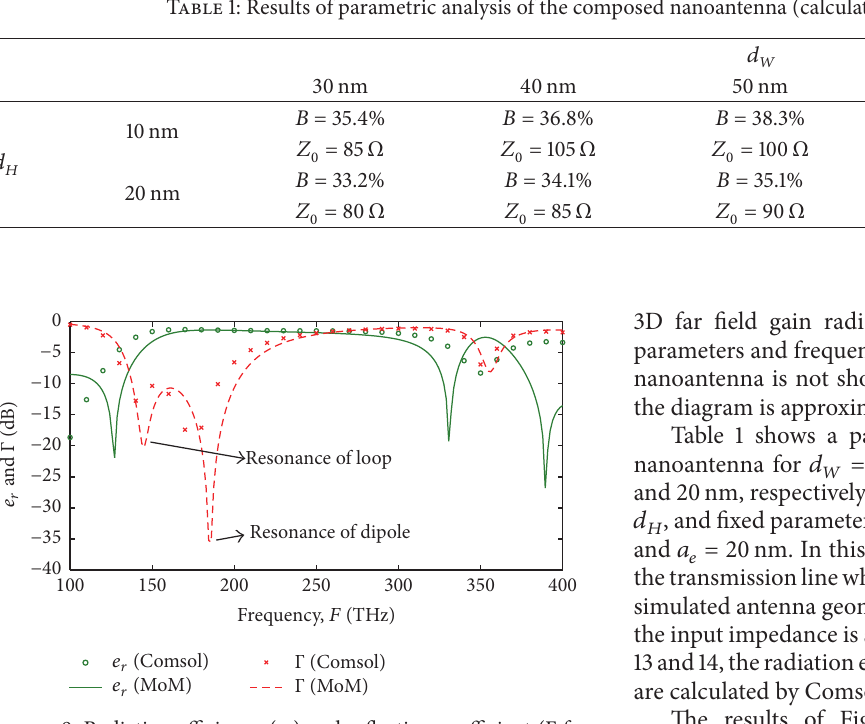
Figure 9: Radiation efficiency ( 𝑒 𝑟 ) and reflection coefficient ( Γ for Ω ) of the composed nanoantenna as a function of frequency, 𝑍 0 = 90 calculated through MoM and